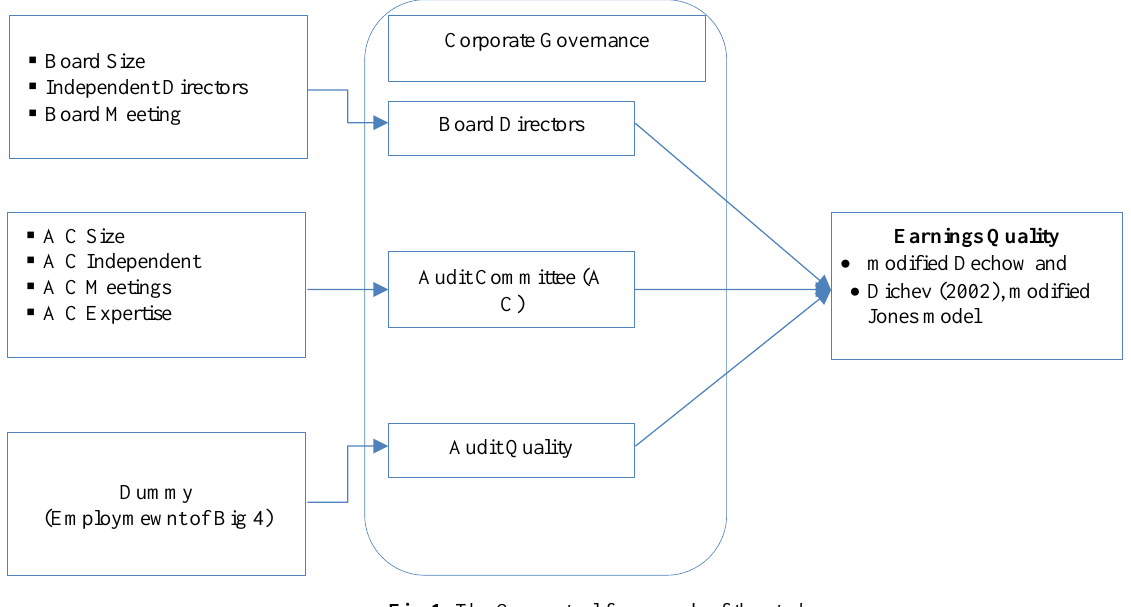
Fig. 1: The Conceptual framework of the